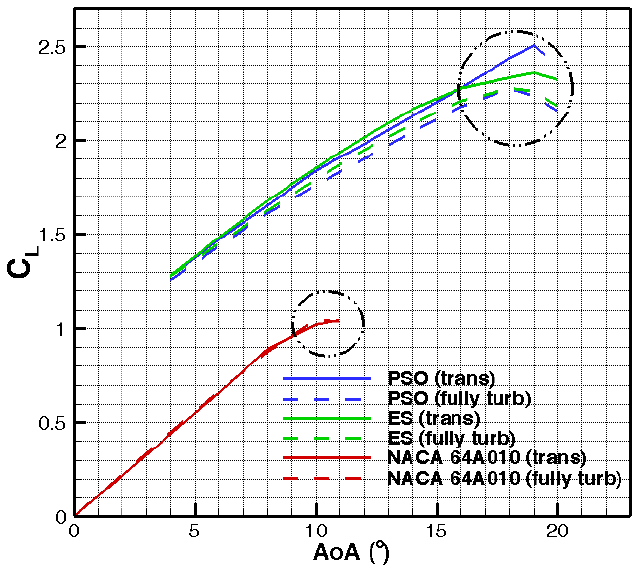
Figure 17. Comparison between fully turbulent and transitional flow C L polars, for the PSO and ES airfoils, as well as for the NACA 64A010. The marked regions denote the appearance of C L,max and the operation points of interest. Flow simulations performed using MaPFlow. Table 8. Relative increase of C L,max of the PSO and ES airfoils, for fully turbulent and transitional flow, simulations performed by MaPFlow.